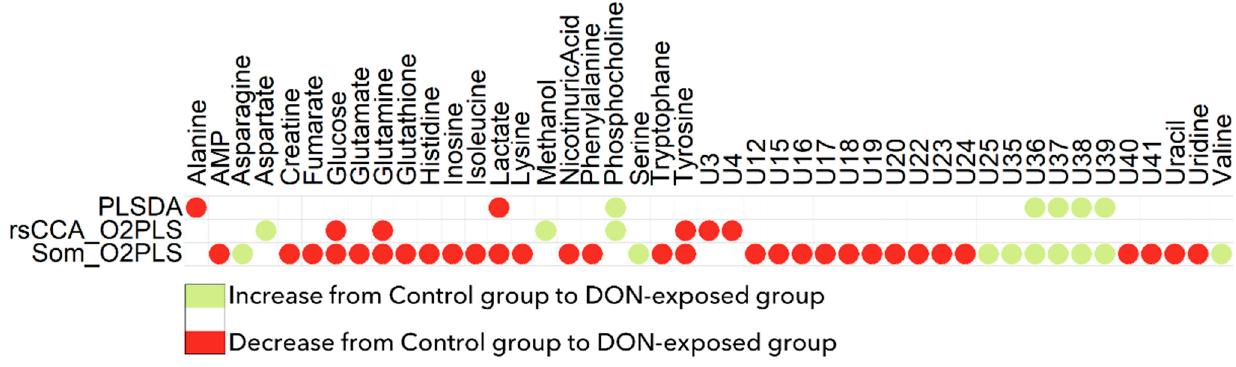
Figure 2. Comparison of metabolites found to be discriminant by PLS-DA (upper line), Robust sparse CCA+O2-PLS-DA (middle line), or SOM+O2-PLS-DA (lower line).